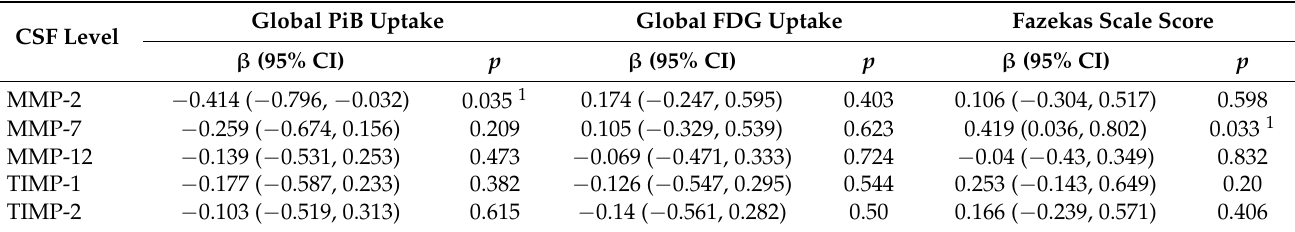
Table 2. Multiple regression model between CSF MMPs and TIMPs levels and global PiB uptake, global FDG uptake, and Fazekas scale score.